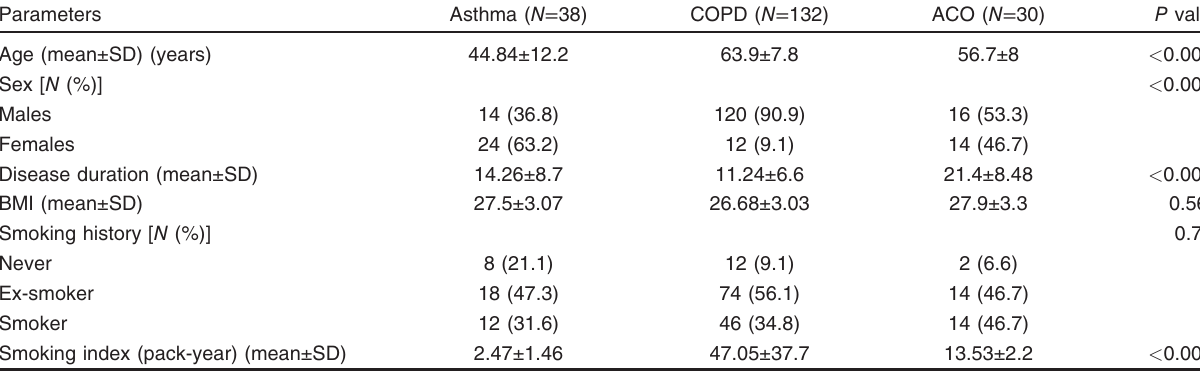
Table 1 Comparison of baseline clinical characteristics of the studied groups